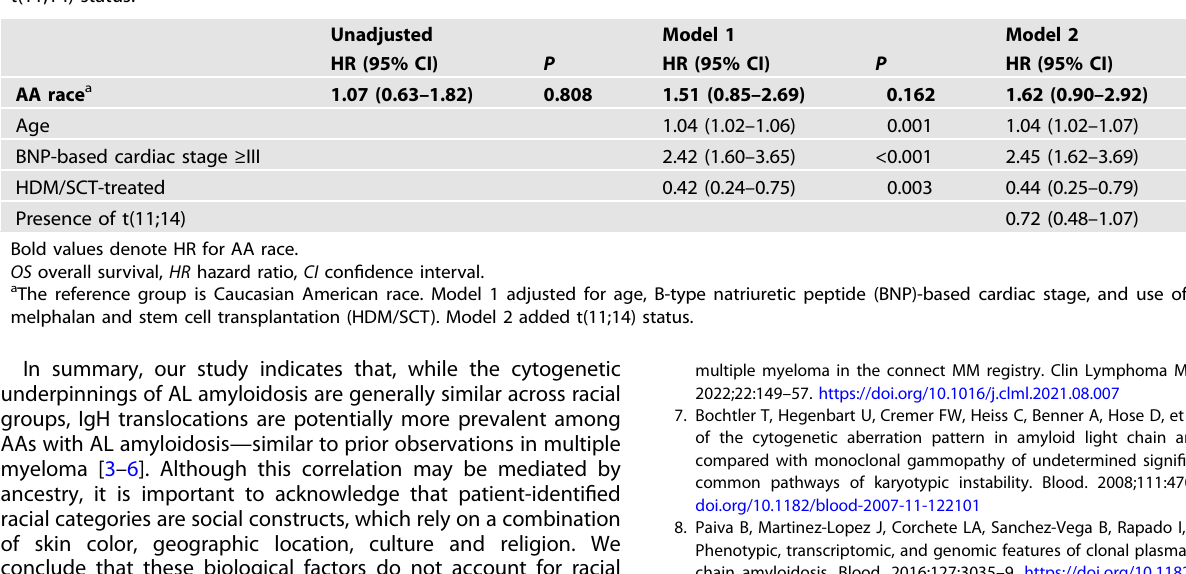
Table 2. Cox proportional hazard regression analysis of all-cause mortality for African American (AA) race, with adjustment for clinical factors and t(11;14)